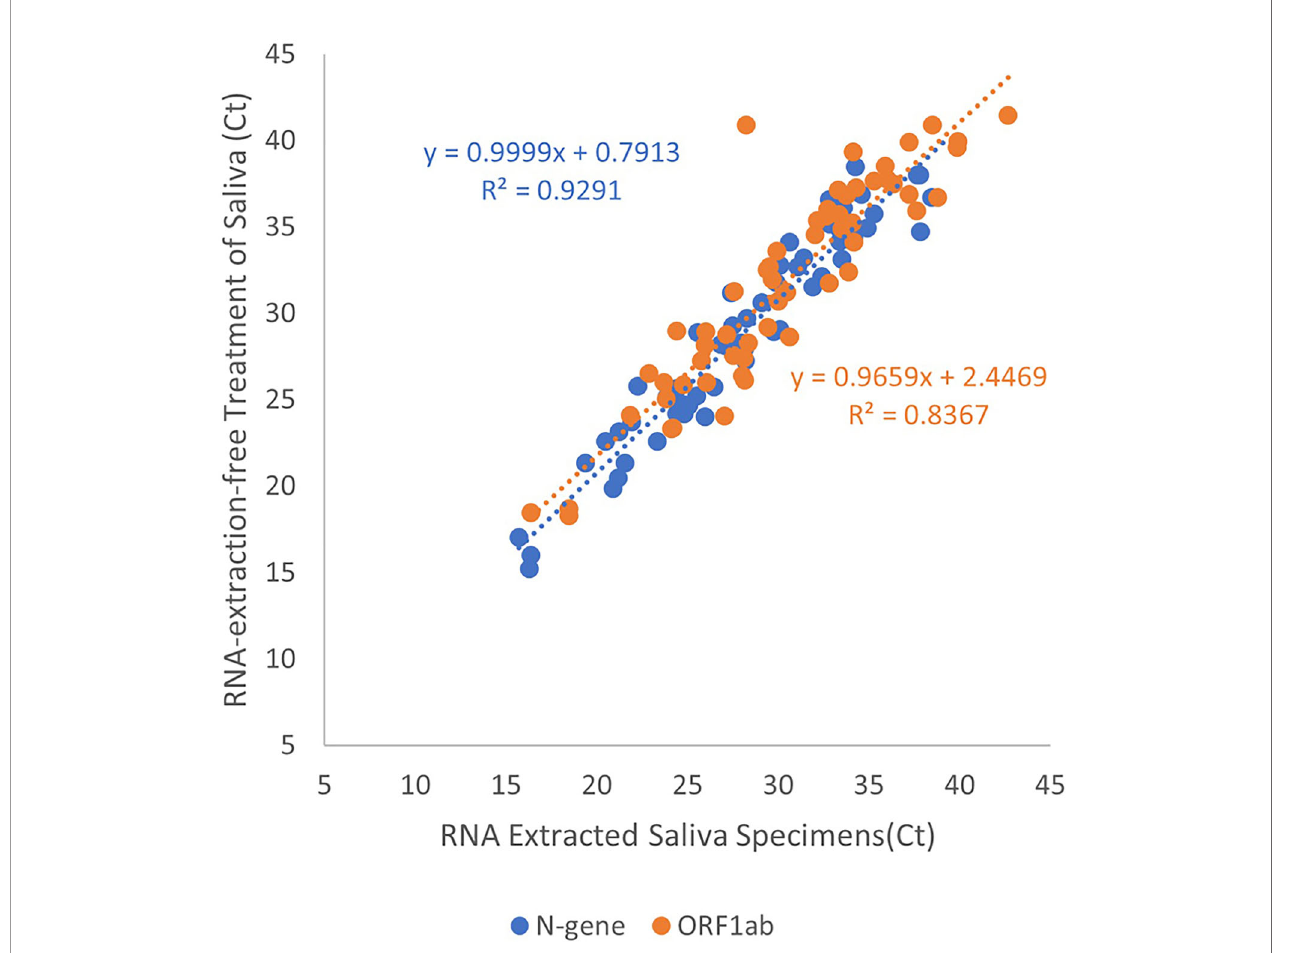
FIGURE 2 | Linear regression of Ct values obtained from adding RNA extracted or heated-only saliva for RT-qPCR template. Data points in blue indicate Ct values for the detection of N-gene while orange for the detection of ORF1ab. Results obtained from extracted RNA from saliva specimens were plotted on the x-axis, with heated-only saliva on the y-axis. The line of best fi t was plotted for both target genes to display a direct proportion between the two